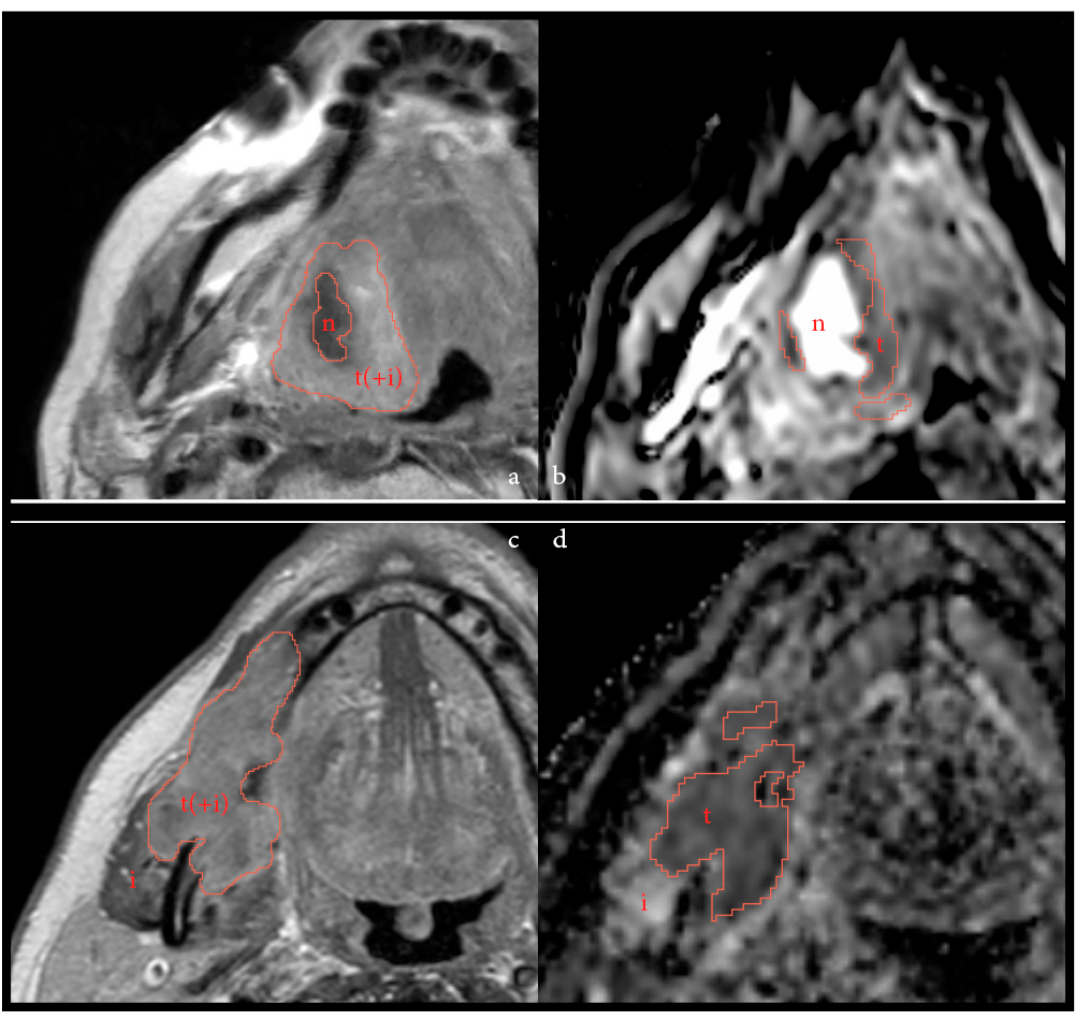
Figure 4. Two different patients illustrating possible tumor microenvironments on T1Wc imaging and on ADC. Figure 4a and b depict pre-immunotherapy imaging of a patient with a residual tumor (rT3N0) after previous CRT with a necrotic area ( n ) within the tumor region (t) on T1Wc ( a ), and as shown on ADC-map ( b ). On the T1Wc imaging, a possible infiltrate (i) could be included in the tumor area, marked by t(+i), as this is difficult to discern. This patient did not respond to treatment. Figure 4c and d depict post-treatment imaging of a cT4N1 primary tumor of the oral cavity, with possible immune infiltrate (i) surrounding the tumor (t), or, conceivably, within the tumor area (t(+i)) on T1wc ( c ) and ADC-map ( d ). This patient had a partial pathological response to treatment. We constructed a model that yielded a high AUC, underlining the potential value of these parameters when assessed in concert, rather than individually. However, this model was trained and tested on the same limited dataset, and, therefore, was likely